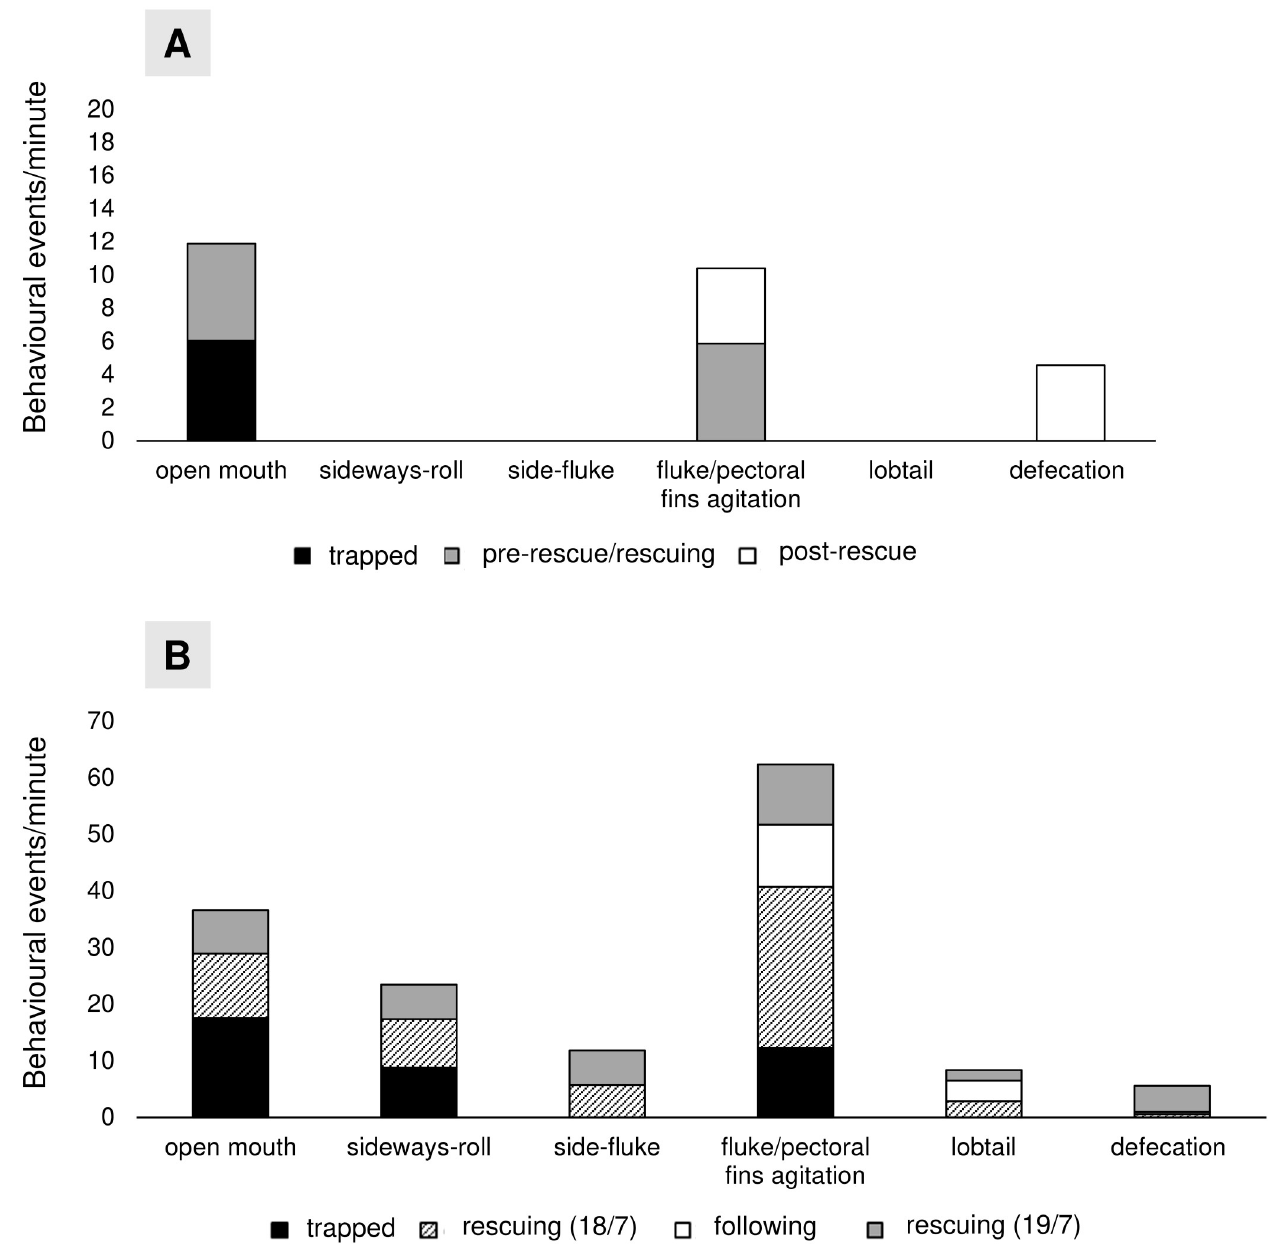
Fig 4. Rate (%) of each behavioural display in different phases. A) First whale. B) Second